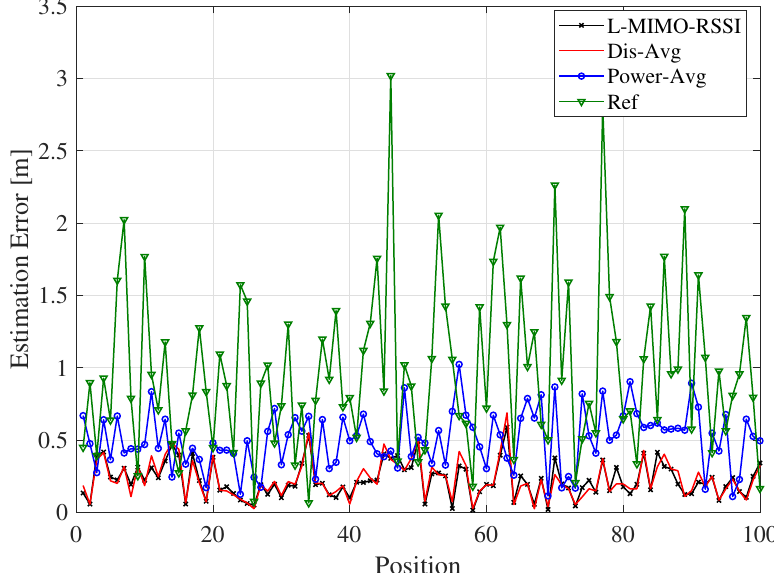
Figure 9. Localization errors change with respect to different random object positions for the LOS environment and the co-polarized antenna